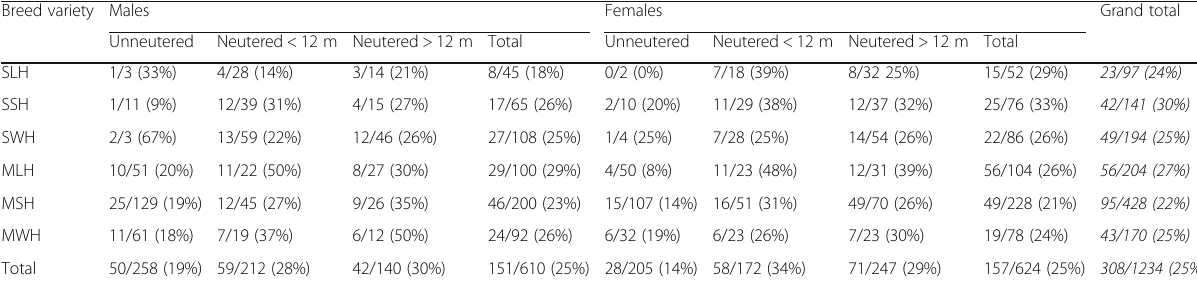
Table 7 Prevalence of IVDH in the six dachshund varieties Breed variety Males